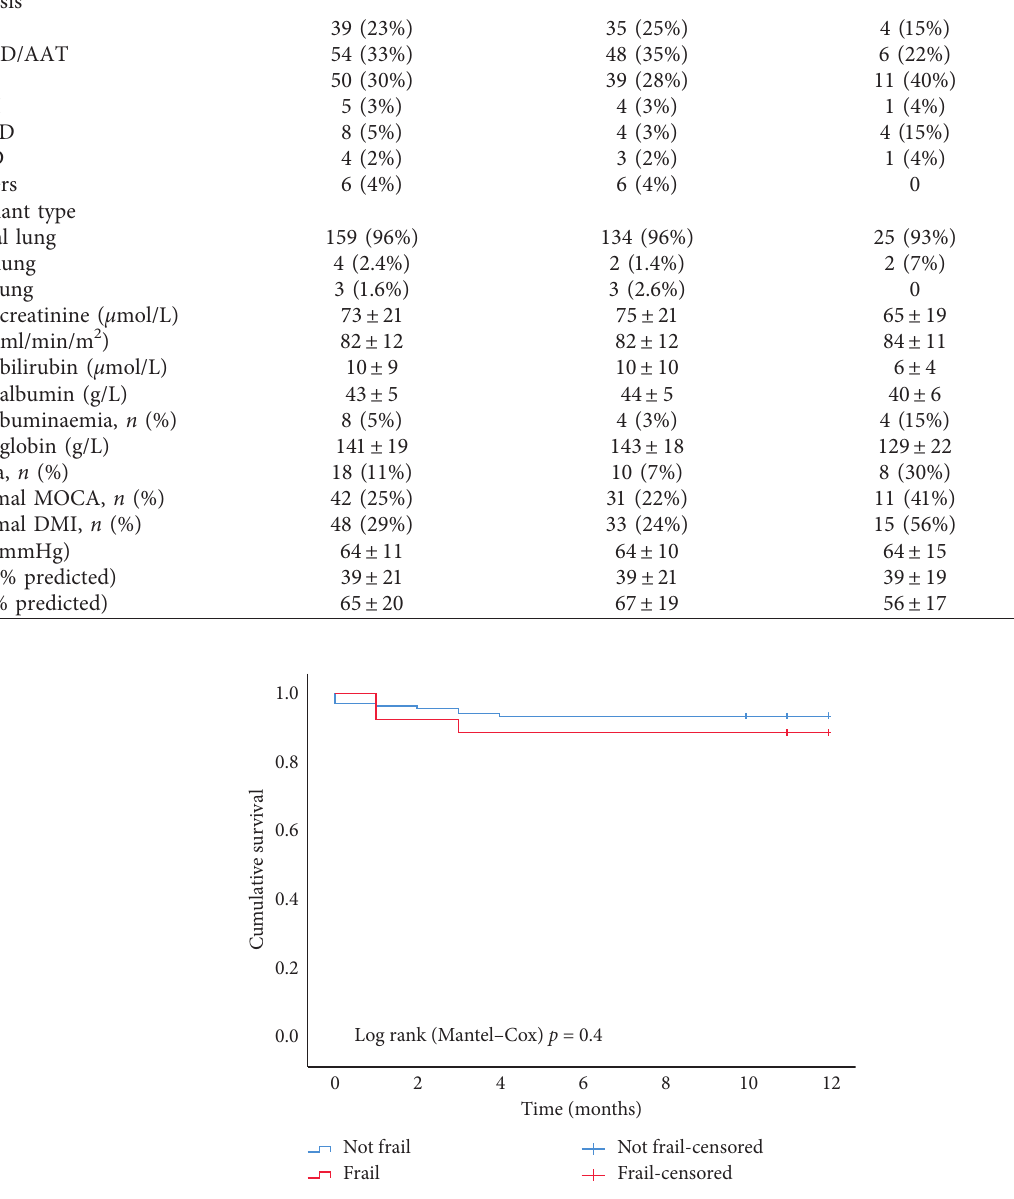
Figure 1: 12-month post-LTX survival in frail vs. nonfrail